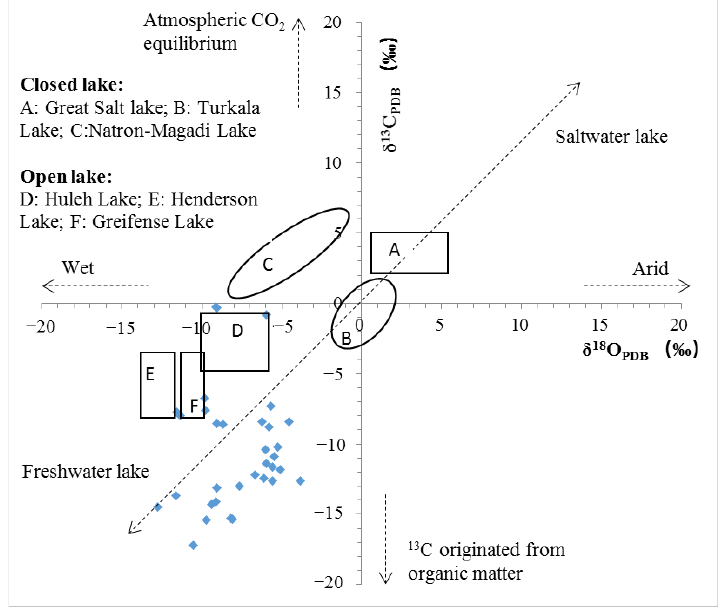
Figure 10. Lacustrine sedimentary type analysis chart [47] based on carbon and oxygen isotope values.